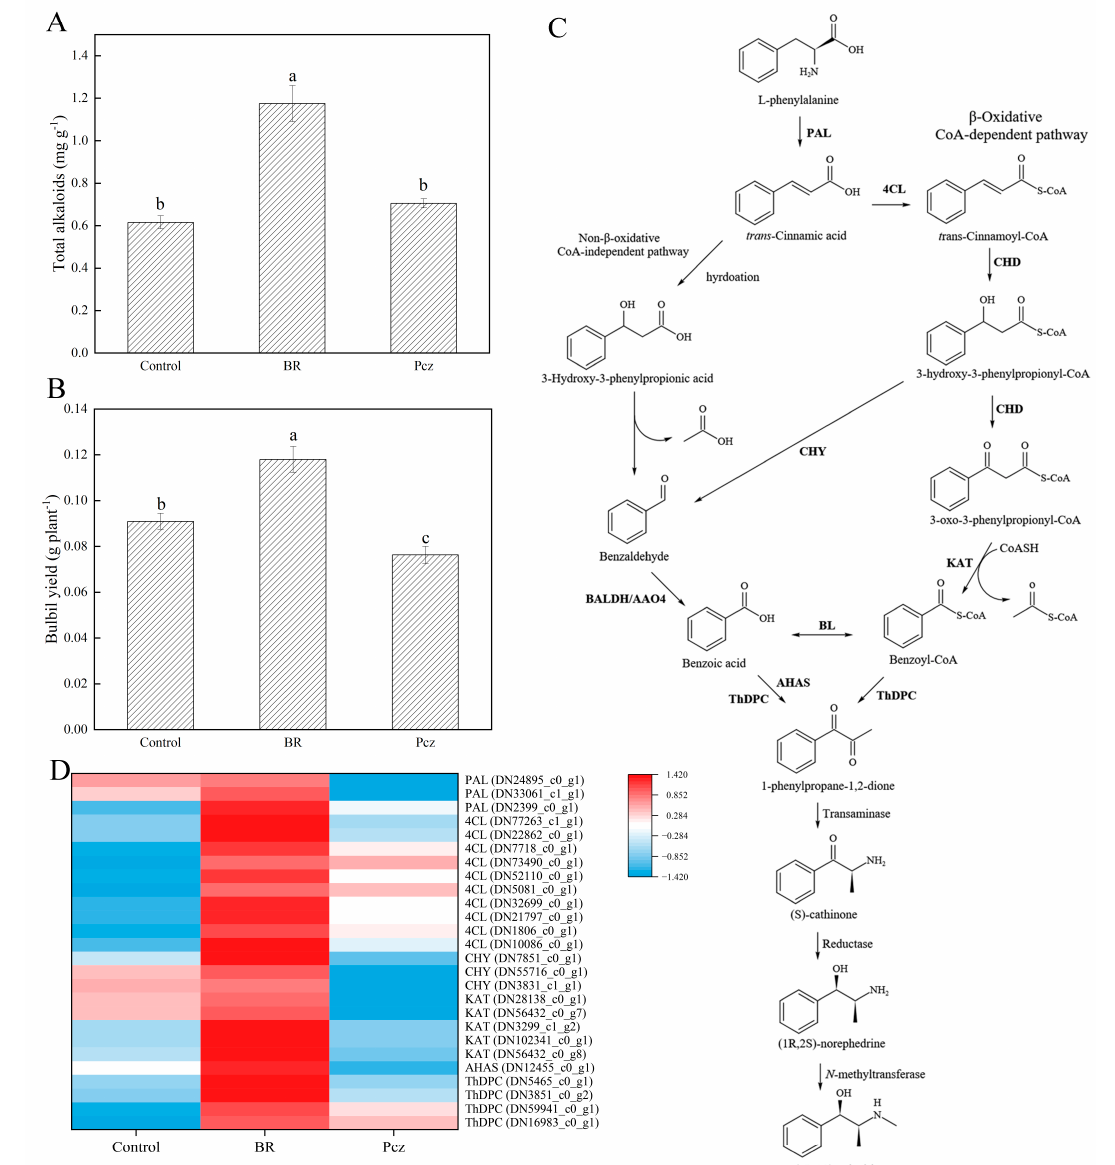
Figure 3. Effects of BR and Pcz treatments on the total alkaloid contents ( A ) and bulbil yield ( B ). The bars with different letters are significantly different from each treatment ( p < 0.05). Values are means of four replicates ± SE. Proposed biosynthetic routes of ephedrine in P. ternata ( C ). Differentially expressed levels of unigenes related to ephedrine biosynthesis ( D ). Changes in expression level are represented by a change in color; blue indicates a lower expression level, whereas red indicates a higher expression level. All data shown reflect the average mean of three biological replicates.